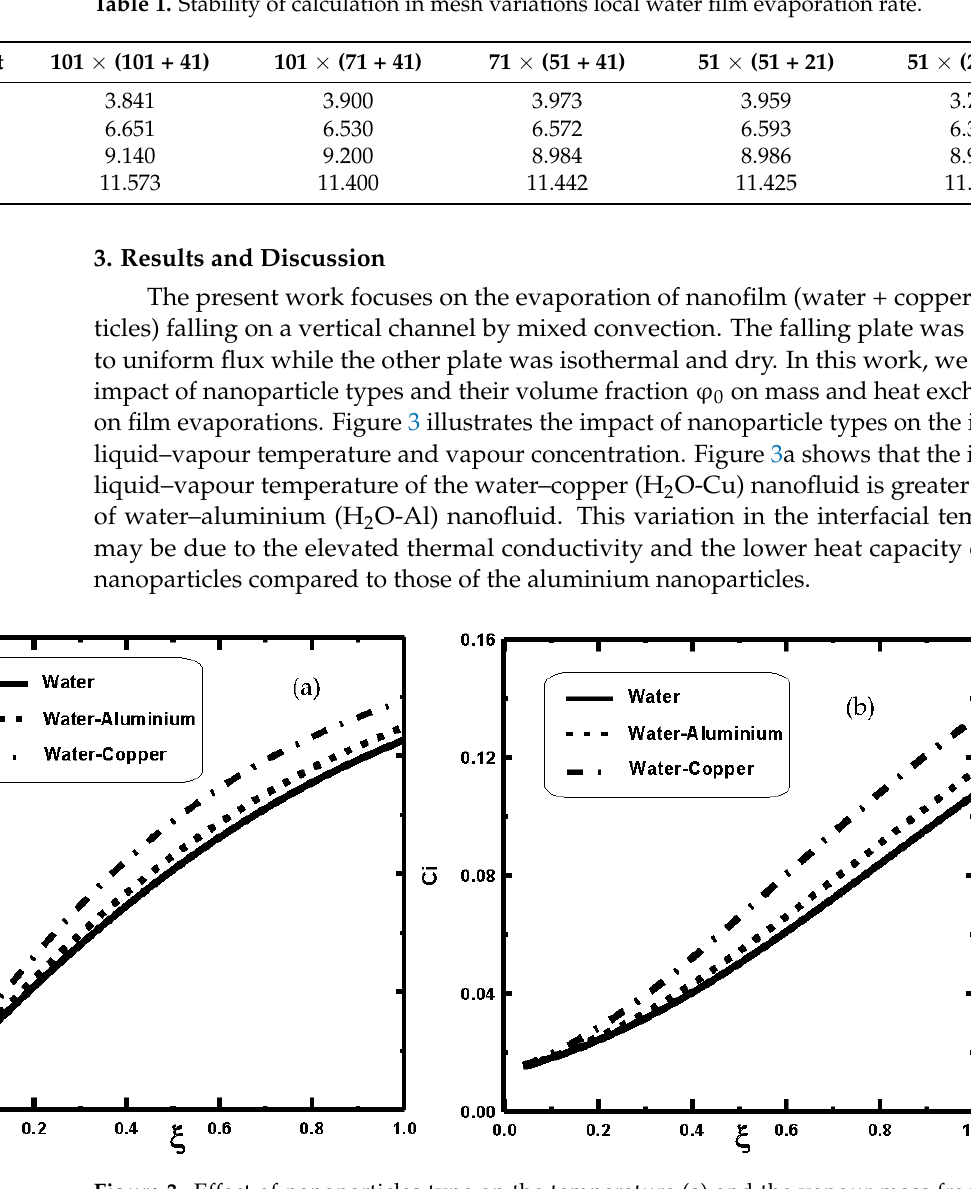
Figure 3. Effect of nanoparticles type on the temperature ( a ) and the vapour mass fraction ( b ) at the interface liquid-gas: T 0 = 20 °C, T 0L = 20 °C, q 1 = 3000 W/m 2 , T w = 20 °C, c 0 = 0, u 0 = 1 m/s, m 0L = 15 × 10 − 4 Kg/m.s, p 0 = 1 atm, d/H = 0.015, φ 0 = 0.05.